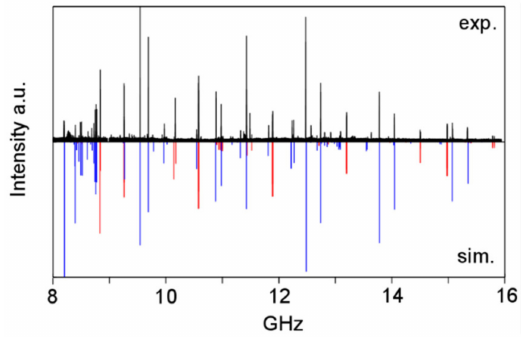
Figure 22. Upper trace: The broadband scan from 8 to 16 GHz of phenyl thioacetate. Lower trace: A predicted spectrum calculated using the parameters of an A0/E0 fit with a standard deviation of 3 MHz. The A species lines are in red, the E species lines in blue [198].